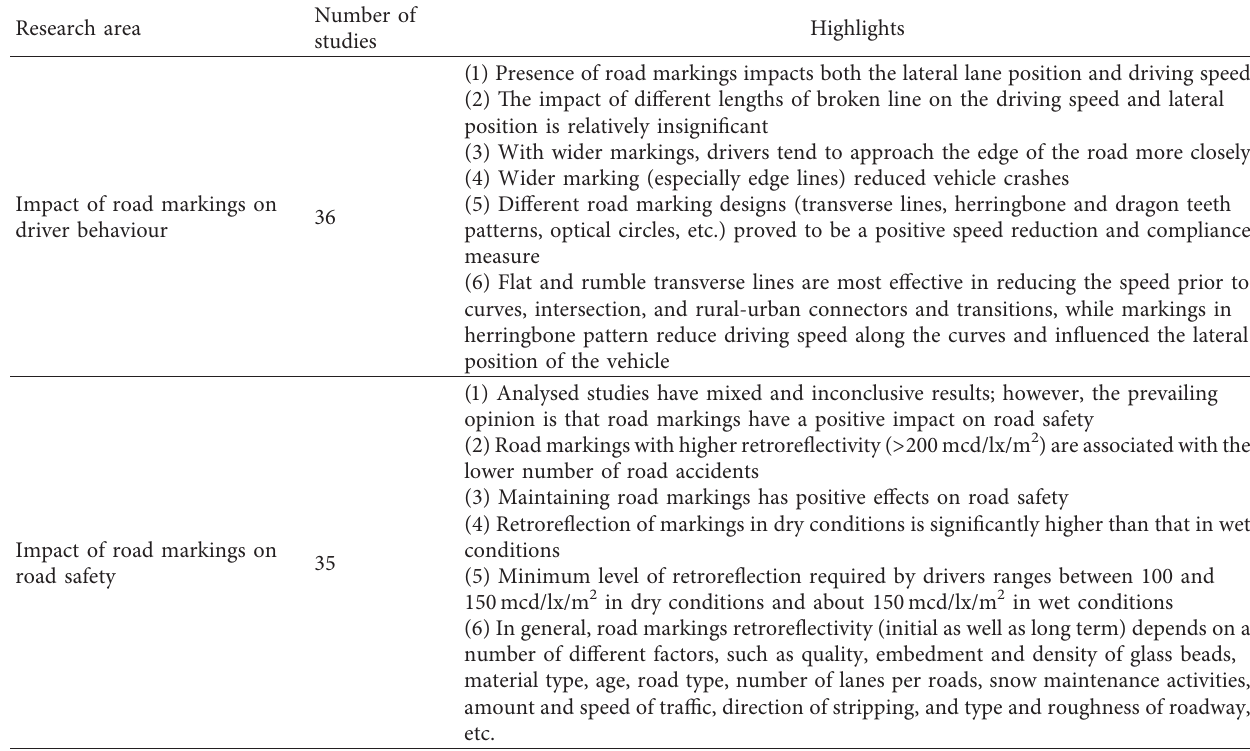
Table 3: Summary of the